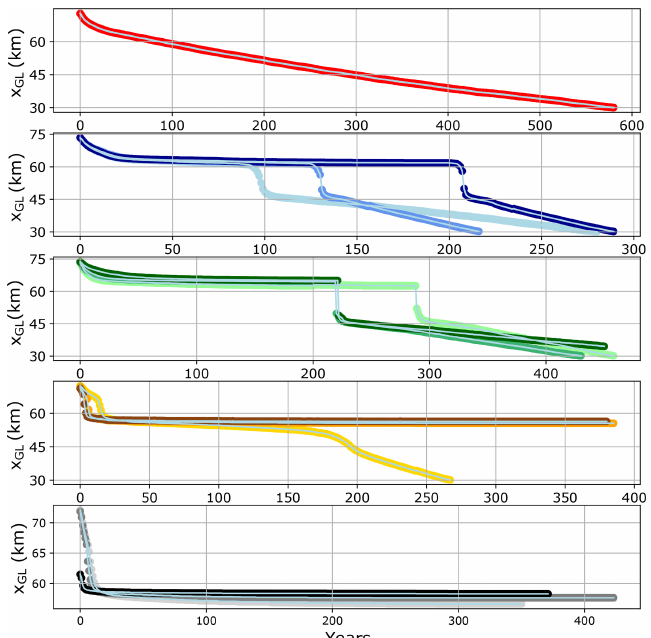
Figure A1. Grounding line position over time for different fjord geometries and magnitudes (for color code refer to Fig. 2). From top to bottom: linear fjord reference run, embayments, depressions, bottlenecks, bumps.